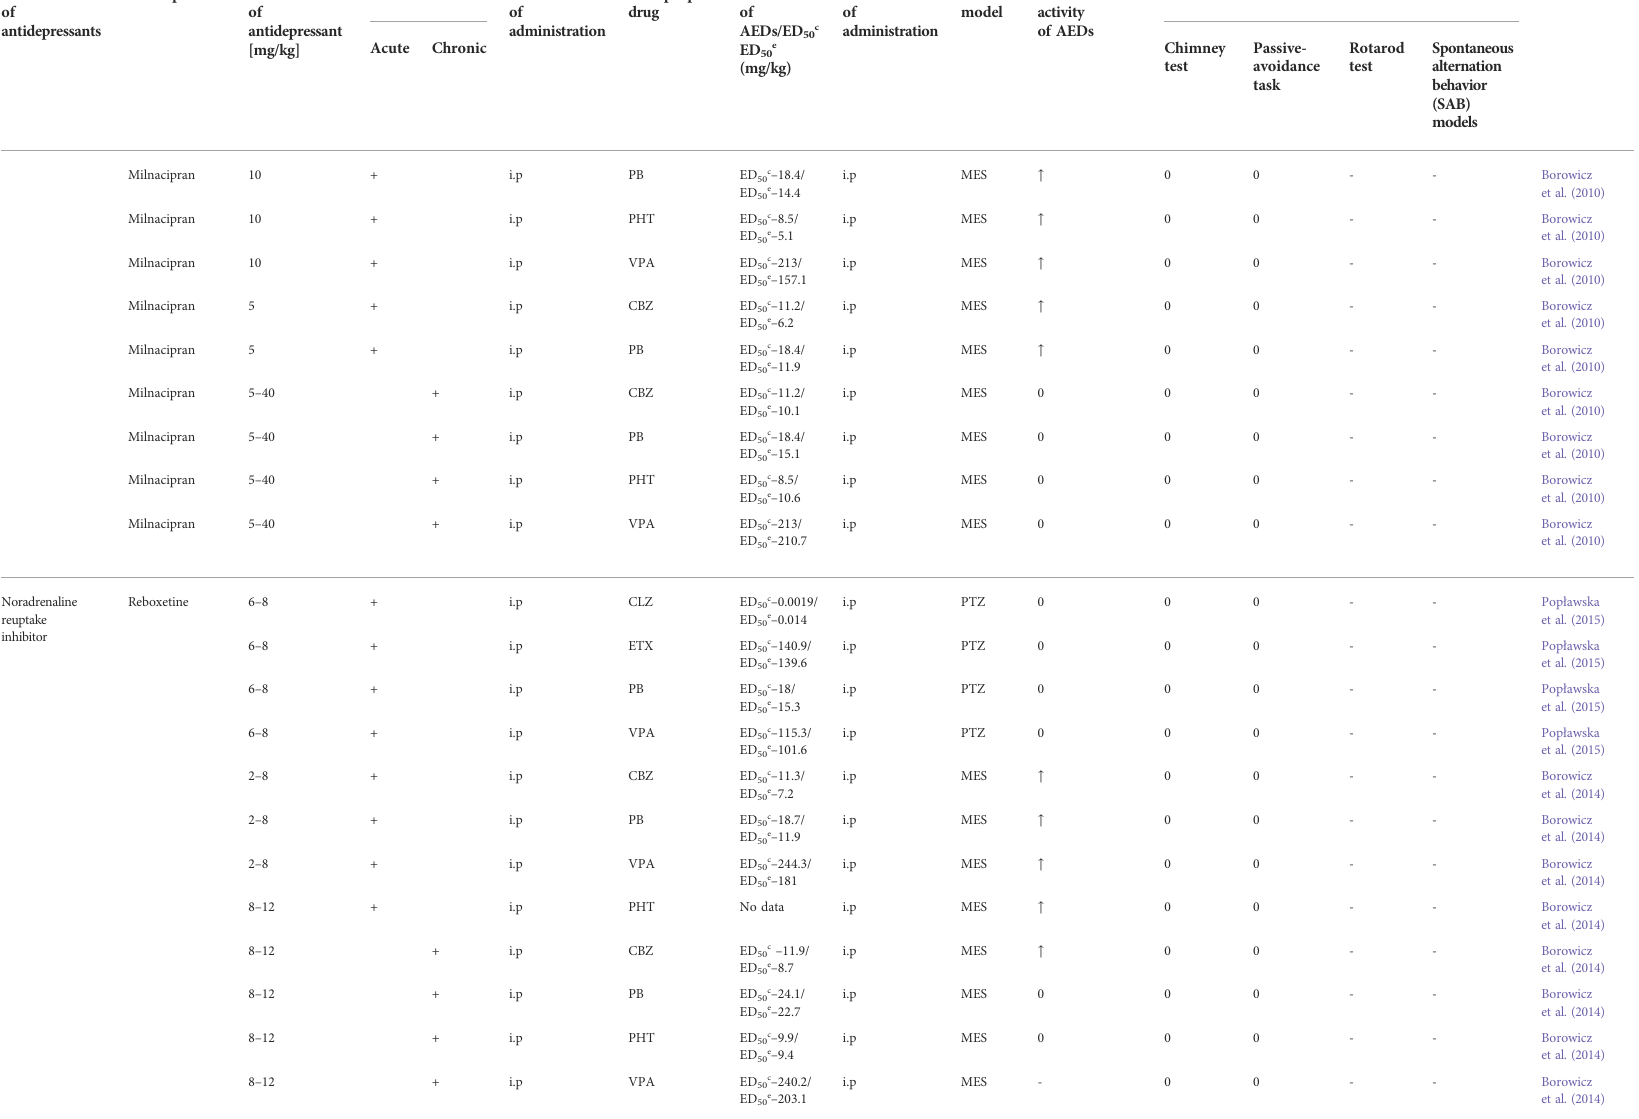
TABLE 2 ( Continued ) Interactions between AEDs and antidepressant drugs in experimental seizure